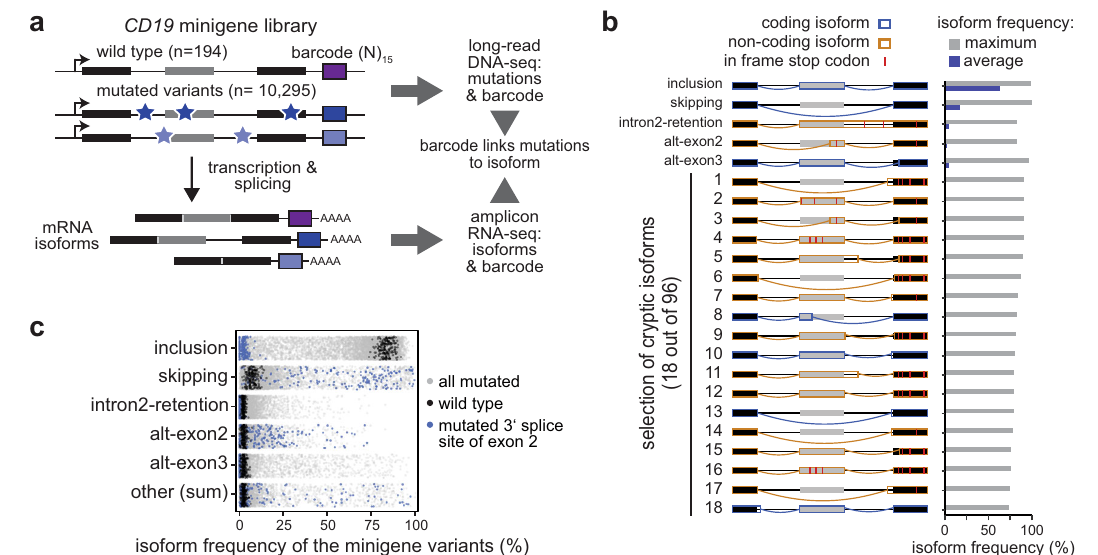
Fig. 2 High-throughput mutagenesis identi fi es splicing-affecting mutations and cryptic isoforms in the CD19 minigene. a High-throughput detection of splicing-affecting mutations and cryptic isoforms. Mutagenic PCR creates mutated minigene variants (top) that upon transfection into NALM-6 cells give rise to alternatively spliced transcripts (bottom). Mutations (stars) and corresponding splicing products are characterised by DNA and RNA sequencing, respectively, and linked by a unique 15-nt barcode sequence in each minigene (coloured boxes). Black and grey boxes depict constitutive and alternative exons, respectively. b A large number of CD19 splice isoforms arise in the minigene library. CD19 splice isoforms with the highest maximal isoform frequency across all 9321 minigene variants. Schematic representation (left) of 5 major and 18 cryptic isoforms depicts exons 1 – 3 (boxes) and introns (horizontal lines) with splice junctions for each isoform (arches). Colour indicates coding potential (blue, coding; orange, non-coding). In-frame stop codons are indicated by red lines. Bar graph (right) shows average and maximal isoform frequency across all minigenes. Cryptic isoforms are sorted by maximal isoform frequency (Supplementary Data 2). c Inclusion isoform dominates in WT minigenes, whereas mutated variants show broad spread in all major isoforms. Frequencies of fi ve major isoforms in replicate 1 for all wild type (black; n = 195) and mutated (grey; n = 9476) minigenes in the library. Minigene variants harbouring a mutation in the 3 ′ splice site of exon 2 ( n = 174) are highlighted in blue. “ Other ” refers to the sum of 96 cryptic